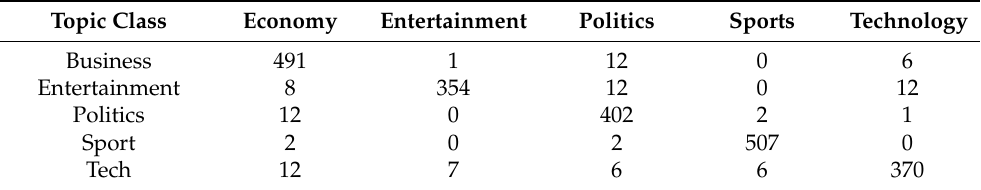
Table 8. Crosstable between preassigned classes and detected dominant topics ( p = 100, γ = 1.0) for all documents of the BBC